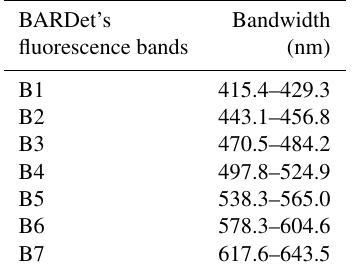
Table 1. Configuration of bands in the multichannel